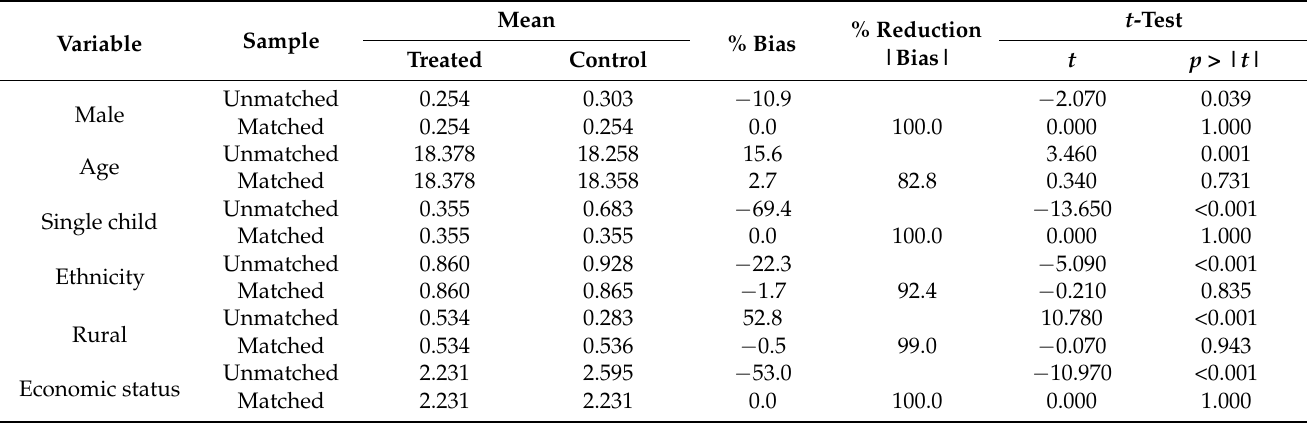
Table 5. One-nearest-neighbor matching and covariate balance in the whole sample.